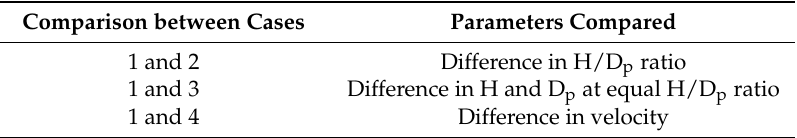
Table 5. Parameter ratios that can be compared between the cases as shown in Table